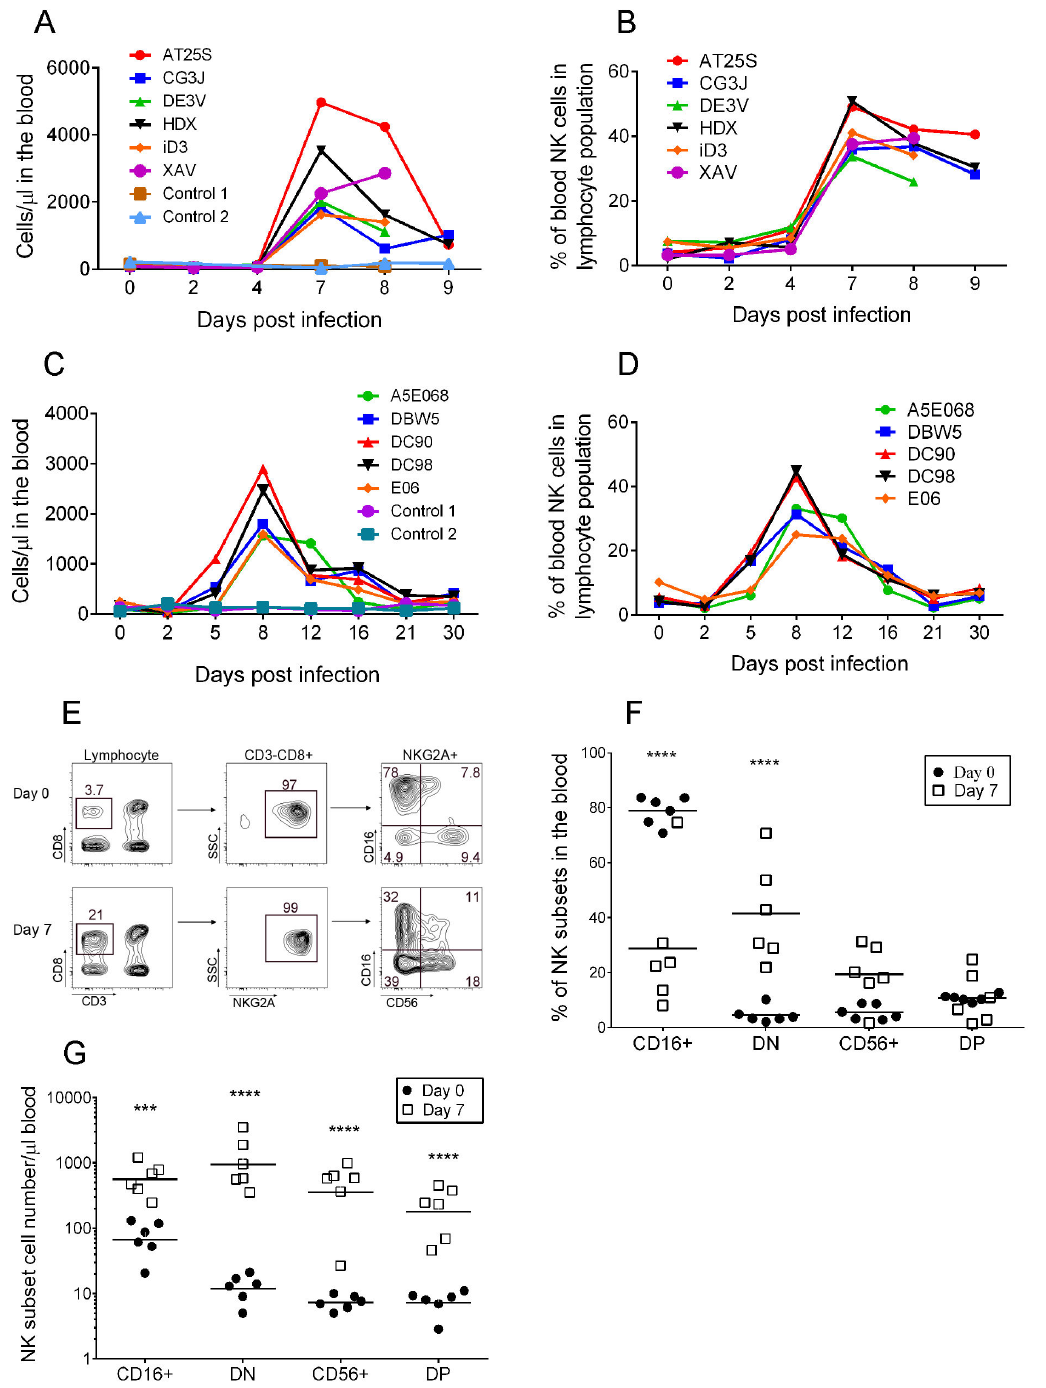
Figure 1. MPXV infection induced increases in NK cell frequency and absolute number in the blood. Kinetics of NK cell total number (A, C) and frequency (B, D) in the blood from experiments A (A, B) and B (C, D), respectively. E) Gating strategy of NK cell subsets from day 0 and day 7 after virus inoculation. F) Frequency of NK cell subsets within the total NK cell gate in the blood at day 7 after virus inoculation (bar represents the median frequency). G) Absolute number of NK cell subsets in the blood at day 7 (bar represents the median NK cell number/µl of blood). Statistical analysis of F) and G) were computed using repeated measures two- way ANOVA in Graph-pad Prism software with Bonferroni post-tests and only significant p values were shown (***p<0.001; and ****p<0.0001). Results were confirmed using bootstrap re-sampling test computed with the R project for statistical computing. doi: 10.1371/journal.pone.0077804.g001 PLOS ONE |